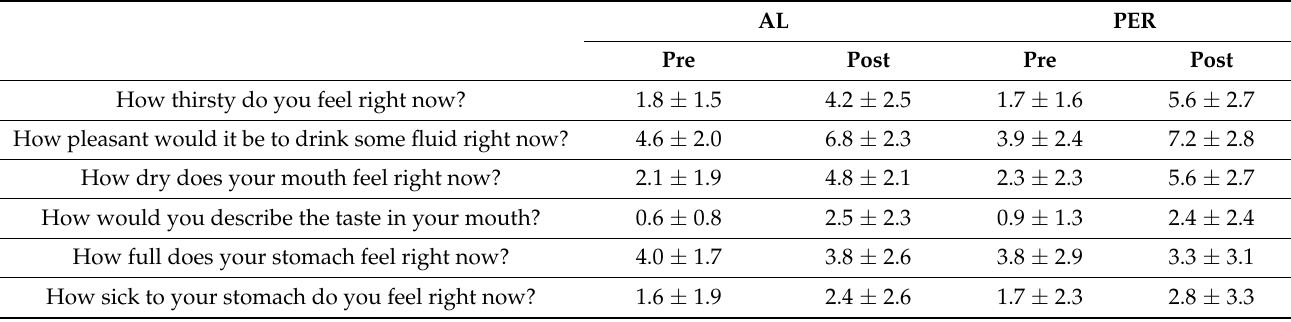
Table 2. Visual analog thirst questionnaire (mm).